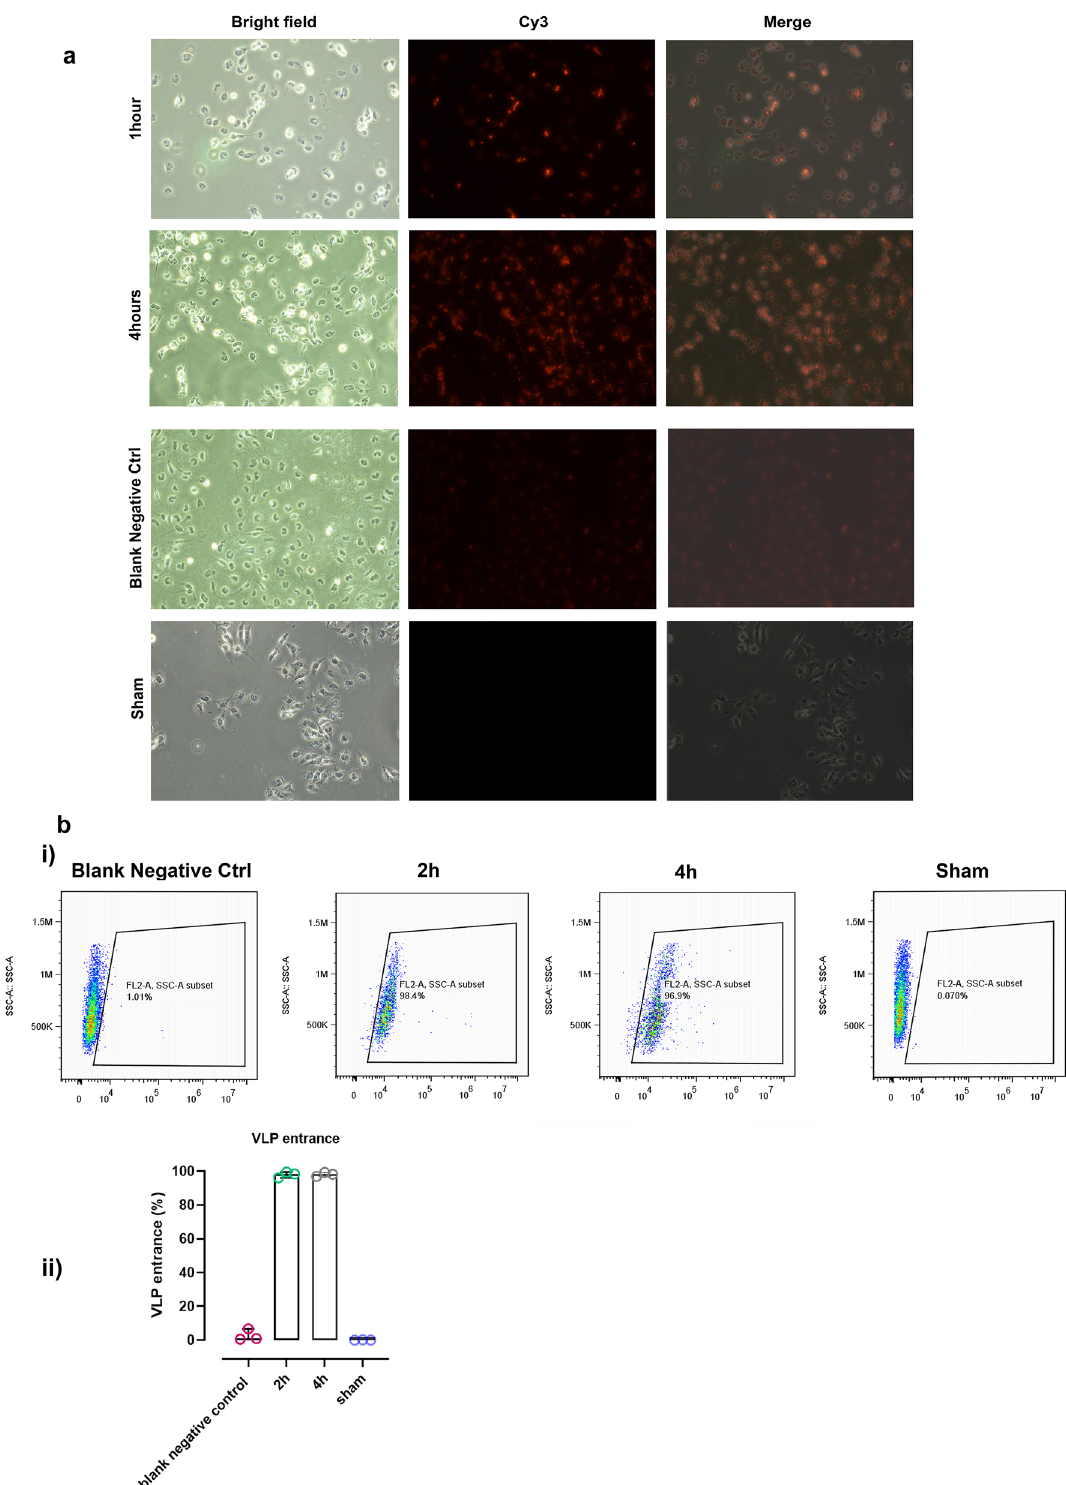
Figure 6. VLPs prepared in NaNO3-Tris buffer can efficiently enter the cells. Neuro2A cells were treated with VLPs prepared in NaNO3-Tris Buffer (0.05 µg/ml). ( a ) Cells were visualized using fluorescent microscopy (Nikon, Japan) in four groups: 1 h and 4 h after VLP treatment, sham (without VLP), and blank negative control (with VLP treatment and without primary antibody) at 100× magnification. Immunocytochemistry images and flow cytometry demonstrated that VLPs (stained with anti MS2 coat protein and secondary-cy3 conjugated antibodies) were internalized by Neuro2A cells effectively. ( b ) i) Intensity plot of cy3 labeled Neuro2A cells in four groups 1 h and 4 h after VLP treatment, sham (without VLP), and blank negative control (with VLP treatment and without primary antibody). ii) diagram representing the average of triplicate results (percentage of the cells with VLP). Data were shown as median with